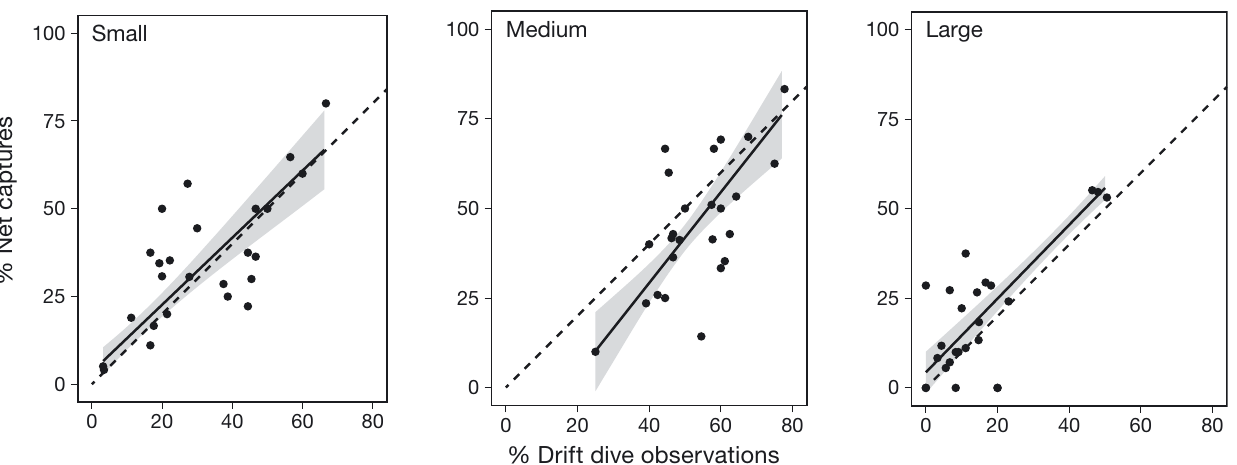
Fig. 4. Comparison of the proportion of size categories (small, medium, and large) of Atlantic salmon between drift diving and net captures. Solid line: fitted line; dashed lines: 1:1 line; shaded areas: 95% credibility intervals